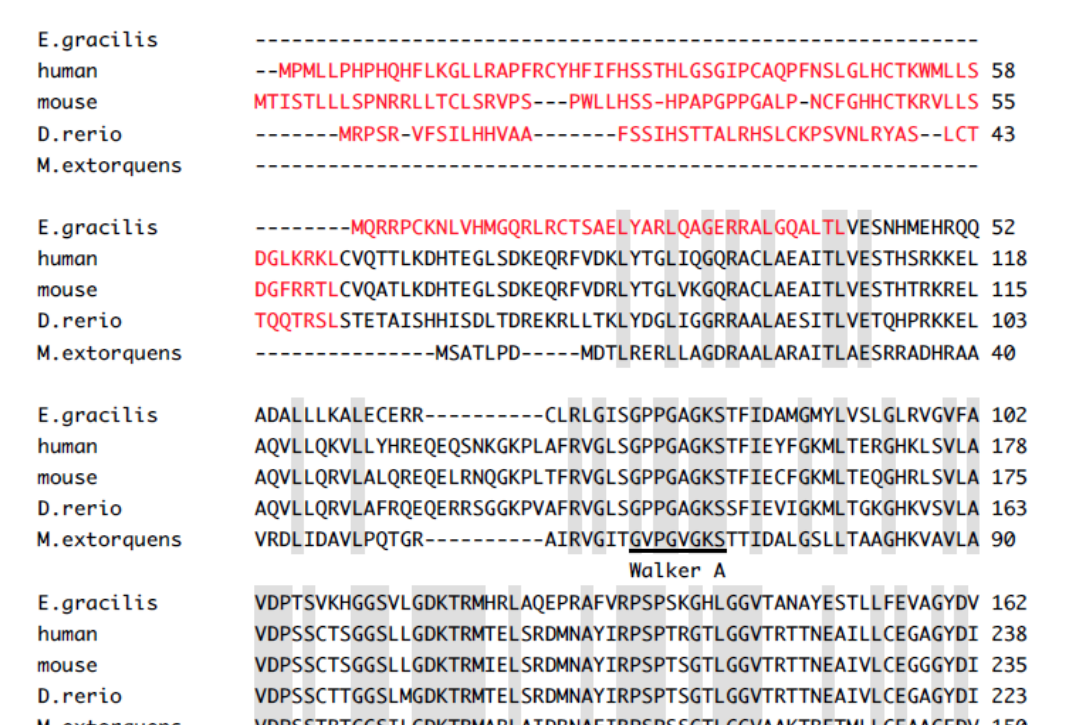
Figure 1. Comparison of the deduced amino acid sequences of MMAA from E. gracilis , human, mouse, D. rerio and meaB from M. extorquens . Sequences were aligned using ClustalW [29]. Sequence motifs defining the G3E family of proteins are indicated, including the GxxGxGK[S/T] Walker A and the DHbHbHbHbE Walker B motif. Hb denotes hydrophobic residues and an [N/T]KxD GTP-binding motif, as described by Leipe et al. [30], is underlined. Red letters indicate the mitochondrial leader sequence. Amino acids that are identical in all species are shaded